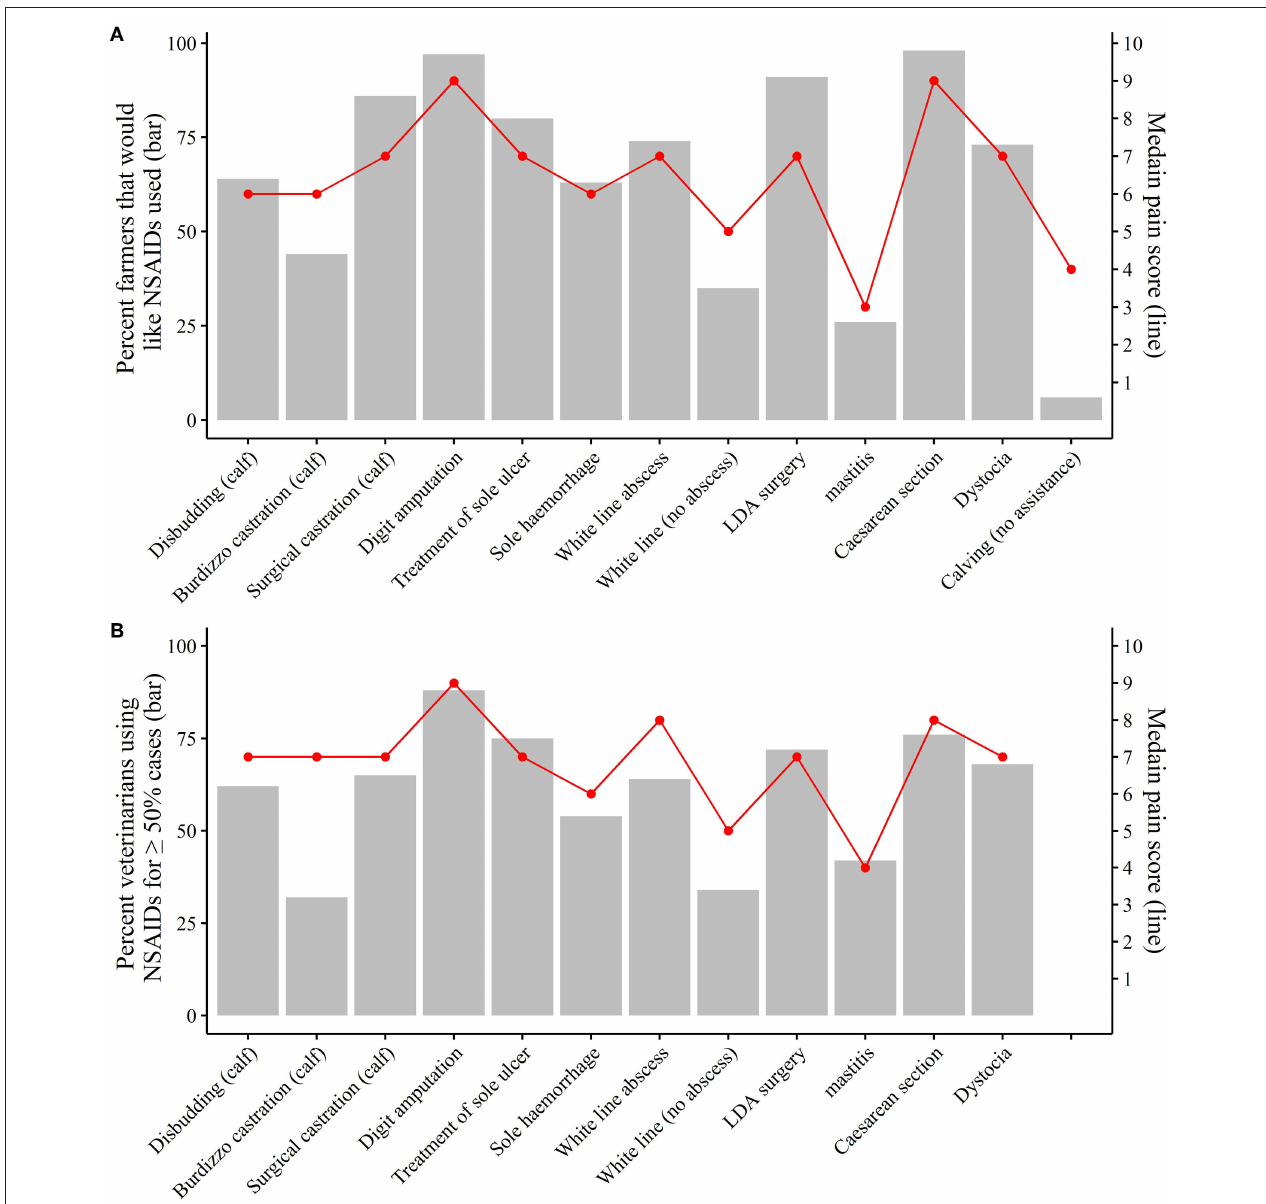
FIGURE 2 | Percentage of farmers that would like NSAIDs used for each condition and procedure ( A ; gray bars) and the percentage of veterinarians that use NSAIDs in ≥ 50% of cases for each condition and procedure ( B ; gray bars), in a survey investigating attitudes to pain and analgesic use in pasture-based dairy cows. Median pain scores are also shown across each condition and procedure for farmer ( A ; red line) and veterinarians ( B ; red